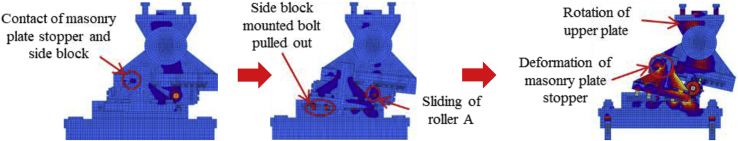
Contact and deformation performance (Case 1).